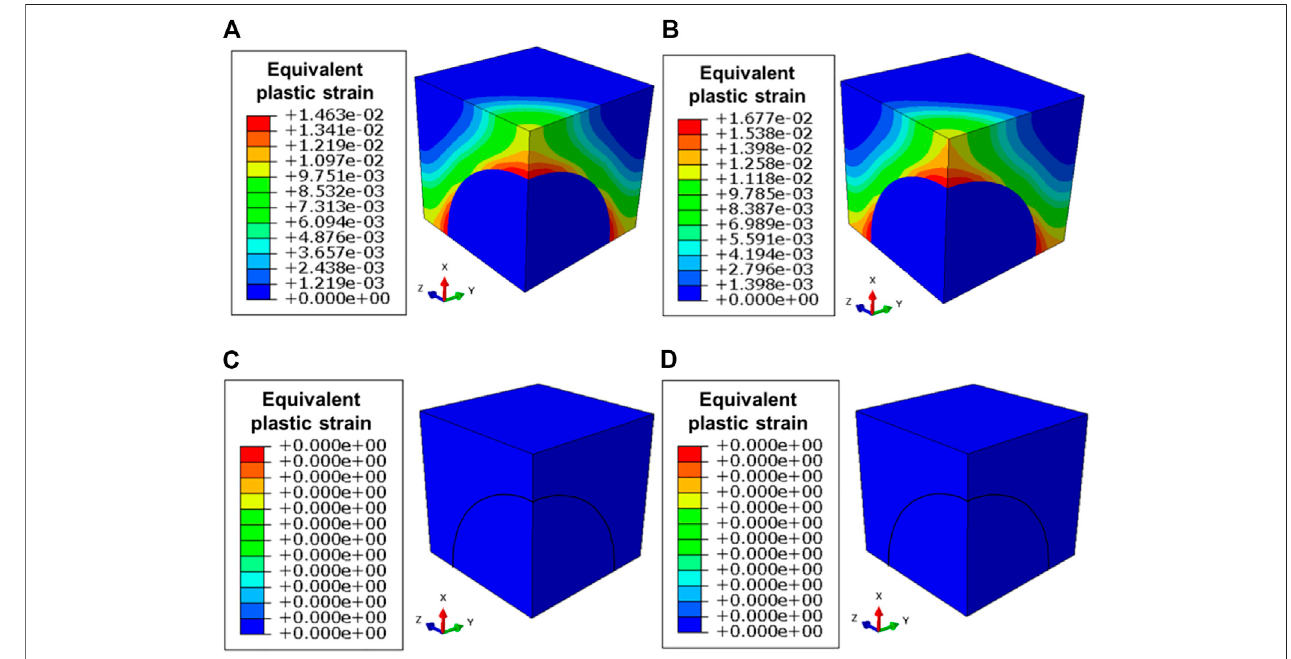
FIGURE 13 | Equivalent plastic strains after irradiation of 8.64 × 10 26 fi ssions/m 3 at temperatures of (A) 473 K, (B) 573 K, (C) 623 K, and (D) 773 K.